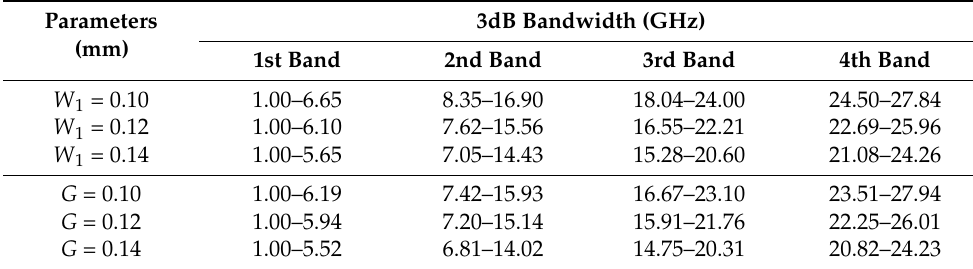
Figure 8. Reflection coefficients of the proposed FSS with different values for ( a ) parameter W 1 ; ( b ) parameter G . Table 2. The 3 dB bandwidths of stopbands with varying W 1 and G.